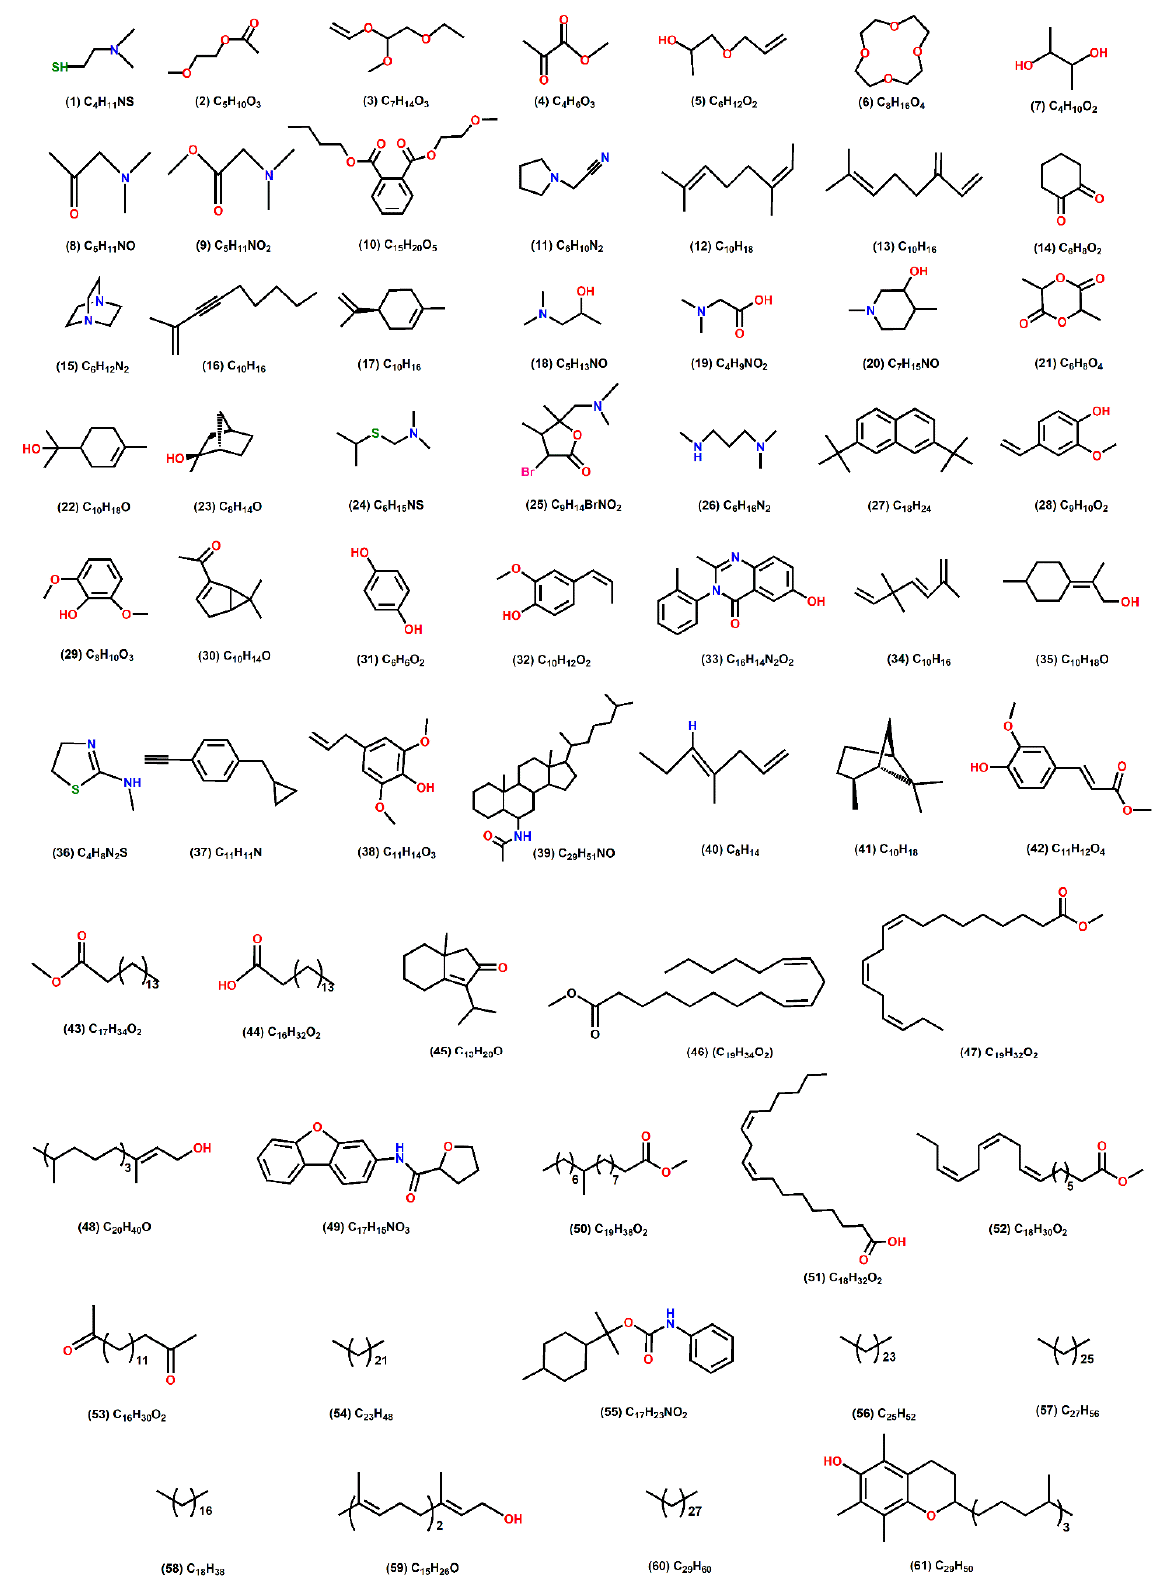
Figure 3. Chemical structure of the different compounds present in the aqueous, methanol and 80% methanol extracts of R. epapposum .